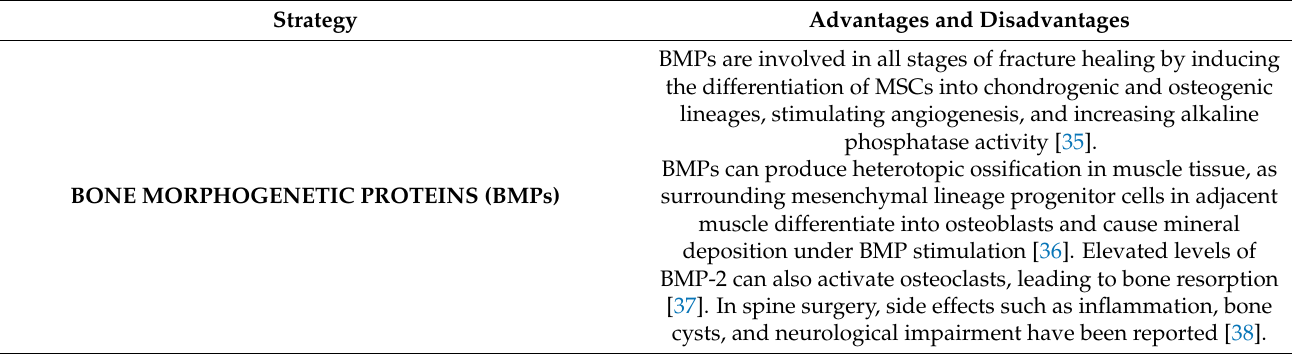
Table 2. Strategies to heal bone defects using BGS combined with biologically active substances.